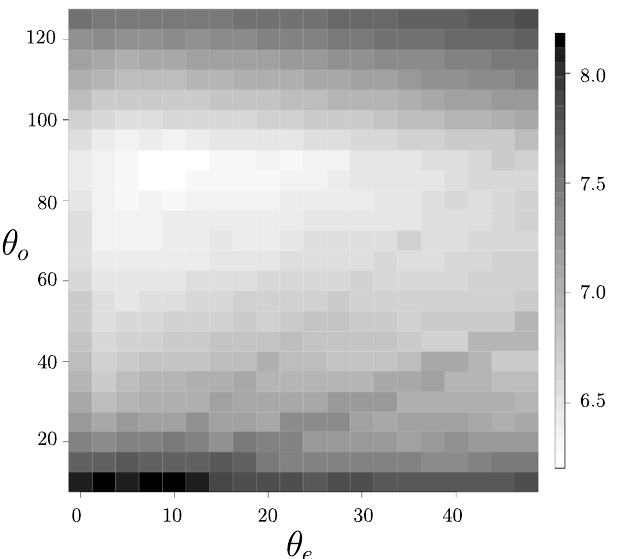
Figure 4. Logarithmic distribution ( z -direction) of the number of times the branches intersects each other in the network as a function of branch angles θ o ( y -direction) and θ e ( x -direction) in degree for a fixed time and